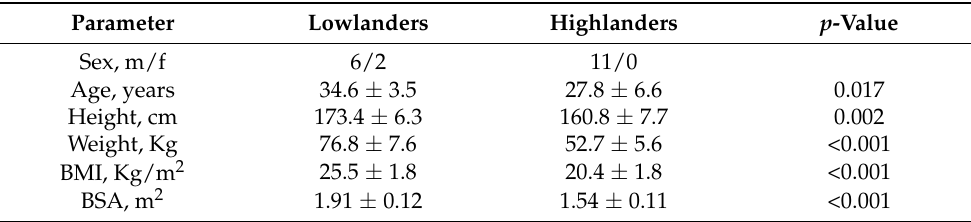
Table 1. Anthropometric characteristics of participants. Parameter Lowlanders Highlanders p -Value Sex,